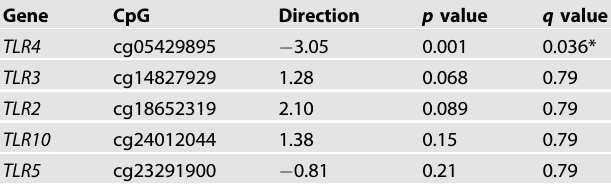
Table 2. Associations between methylation levels and